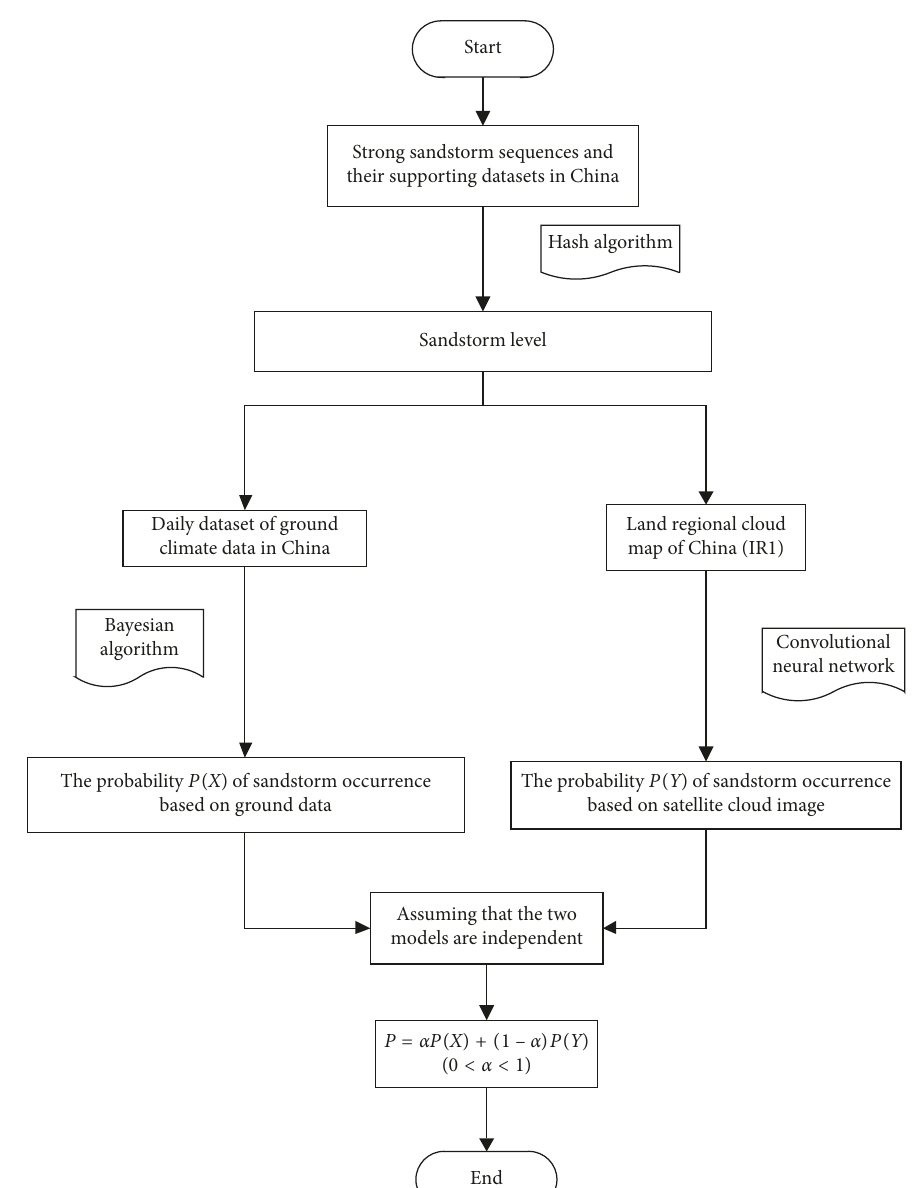
Figure 7: The mathematical principle of the INB-CNN classification